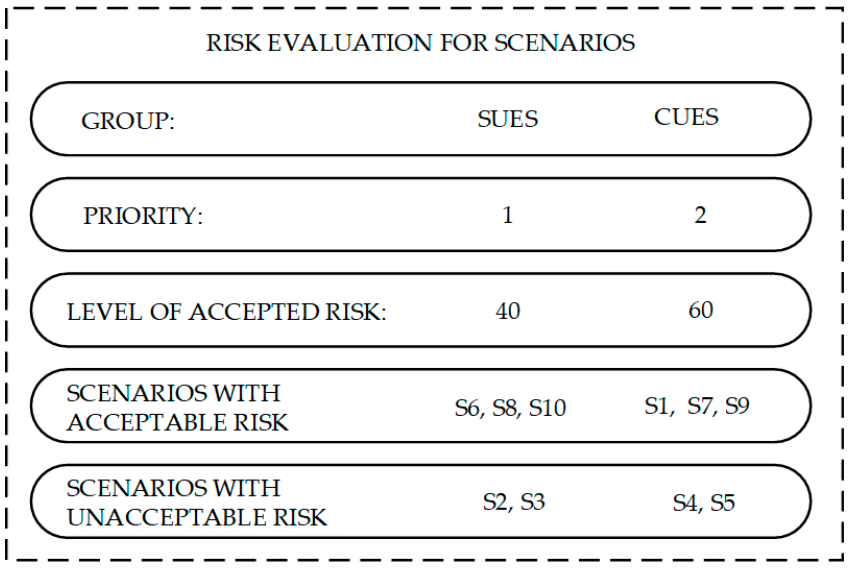
Figure 10. Acceptance level for the assessed scenarios in both analyzed groups.